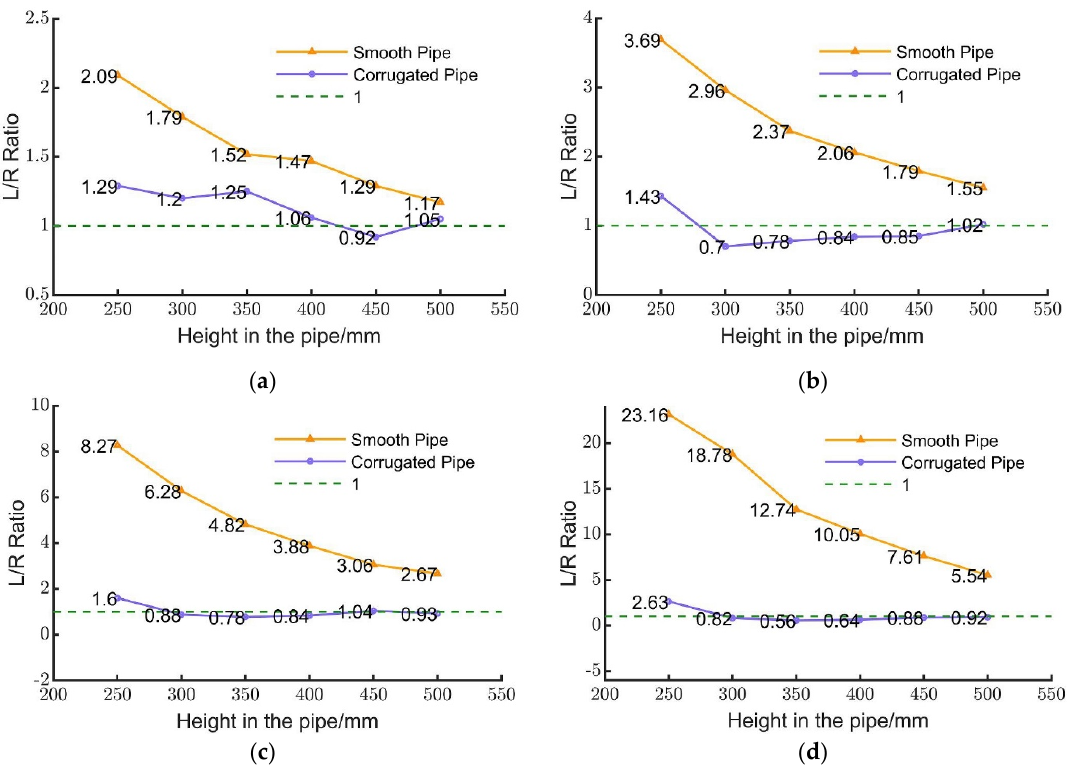
Figure 7. Different bellow positions corresponding to the mass ratio of left and right particles. ( a ) R/D ratio is 0.5; ( b ) R/D ratio is 1; ( c ) R/D ratio is 1.5; ( d ) R/D ratio is 2. In the vertical smooth tube, as the value of R/D gradually increased, the L/R ratio increased significantly, indicating that a larger R/D value was not conducive to the uni- form mixing of particles in the smooth vertical tube. In the vertical bellows, when the R/D value was in the range of 0.5–1, the L/R ratio could converge to around 1 at a vertical tube